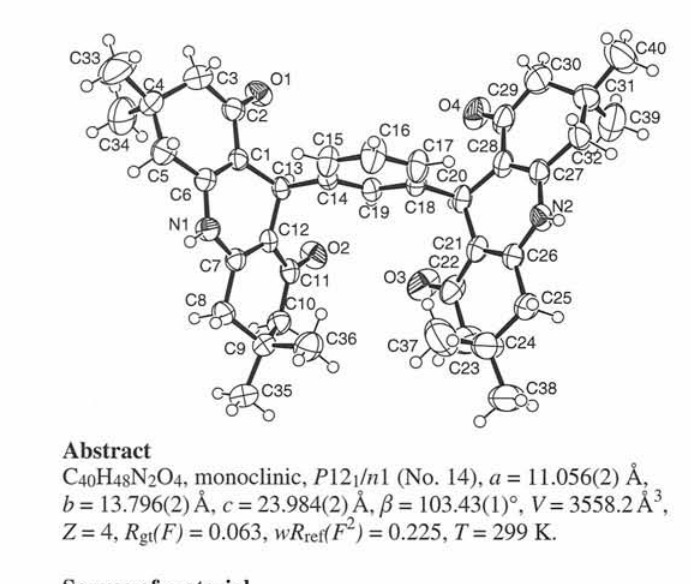
Table 1. Data collection and handling.